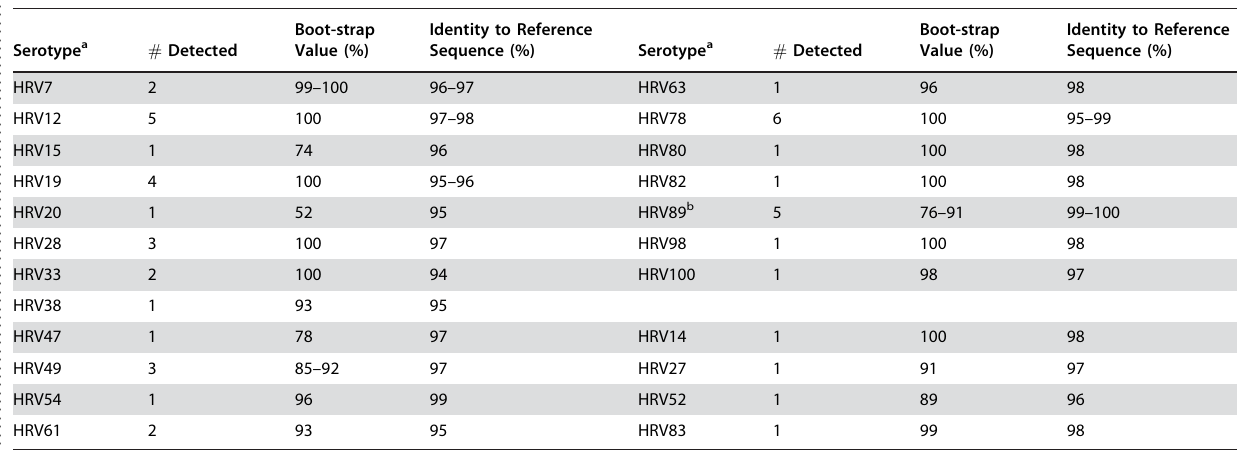
Table 3. Detection of known HRV serotypes in clinical specimens. .. ... .... ... ... .... ... ... .... ... ... .... ... ... .... ... ... .... ... ... .... ... ... .... ... ... .... ... ... .... ... ... .... ... ... .... ... ... .... ... ... .... ... ... . Serotype